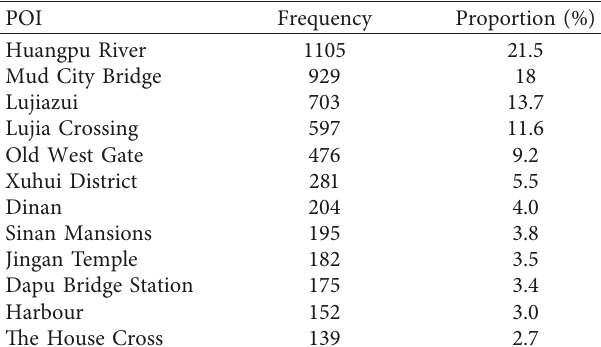
Figure 5: Different attitudes of inbound tourists in different regions determine their shooting styles. Table 1: POI statistics of inbound tourists in Shanghai.